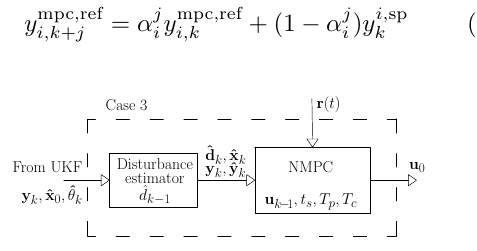
Figure 7: Case 3 NMPC with disturbance